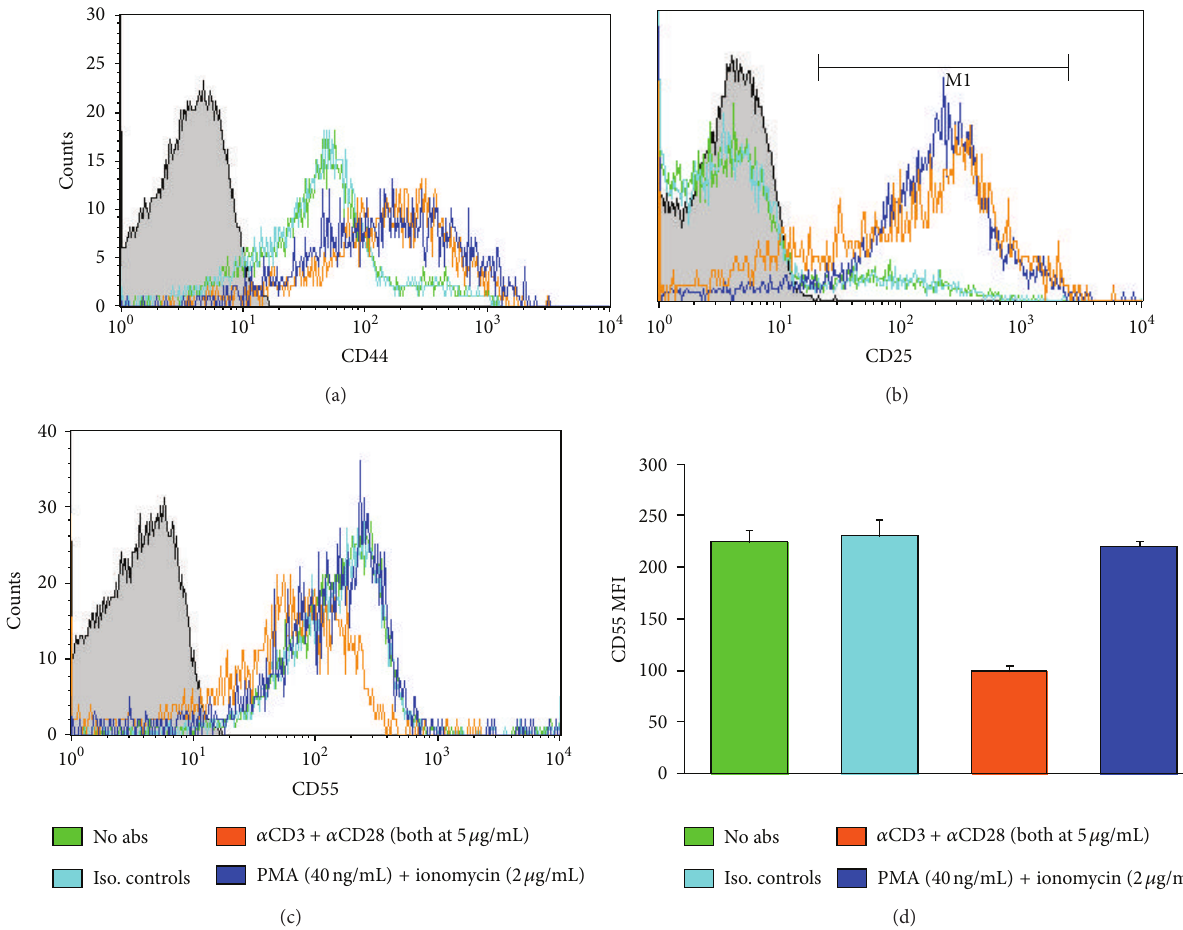
Figure 2: Anti-CD3/anti-CD28 but not phorbol 12-myristate 13-acetate (PMA)/ionomycin lowers CD55 expression of CD4 + T-cells. Lymph node cells from B10.S mice were cultured with no additives (green), Ig isotype controls (light blue), anti-CD3/anti-CD28 (5 𝜇 g/mL each) (orange), or phorbol 12-myristate 13-acetate (PMA) (40 ng/mL) and ionomycin (2 𝜇 g/mL) (dark blue). Cells were incubated at 37 ∘ C and 5% CO 2 for 72hr and then analyzed by flow cytometry to determine activation status (CD 44 hi , CD 25 hi ) and then CD55 expression of activated cells. 𝑛 = 4